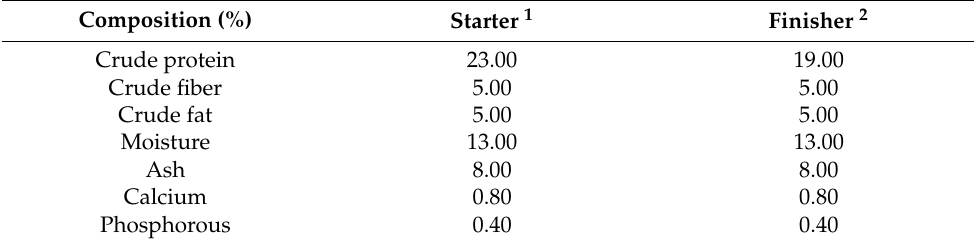
Table 1. Nutrient compositions of commercial broiler starter and finisher